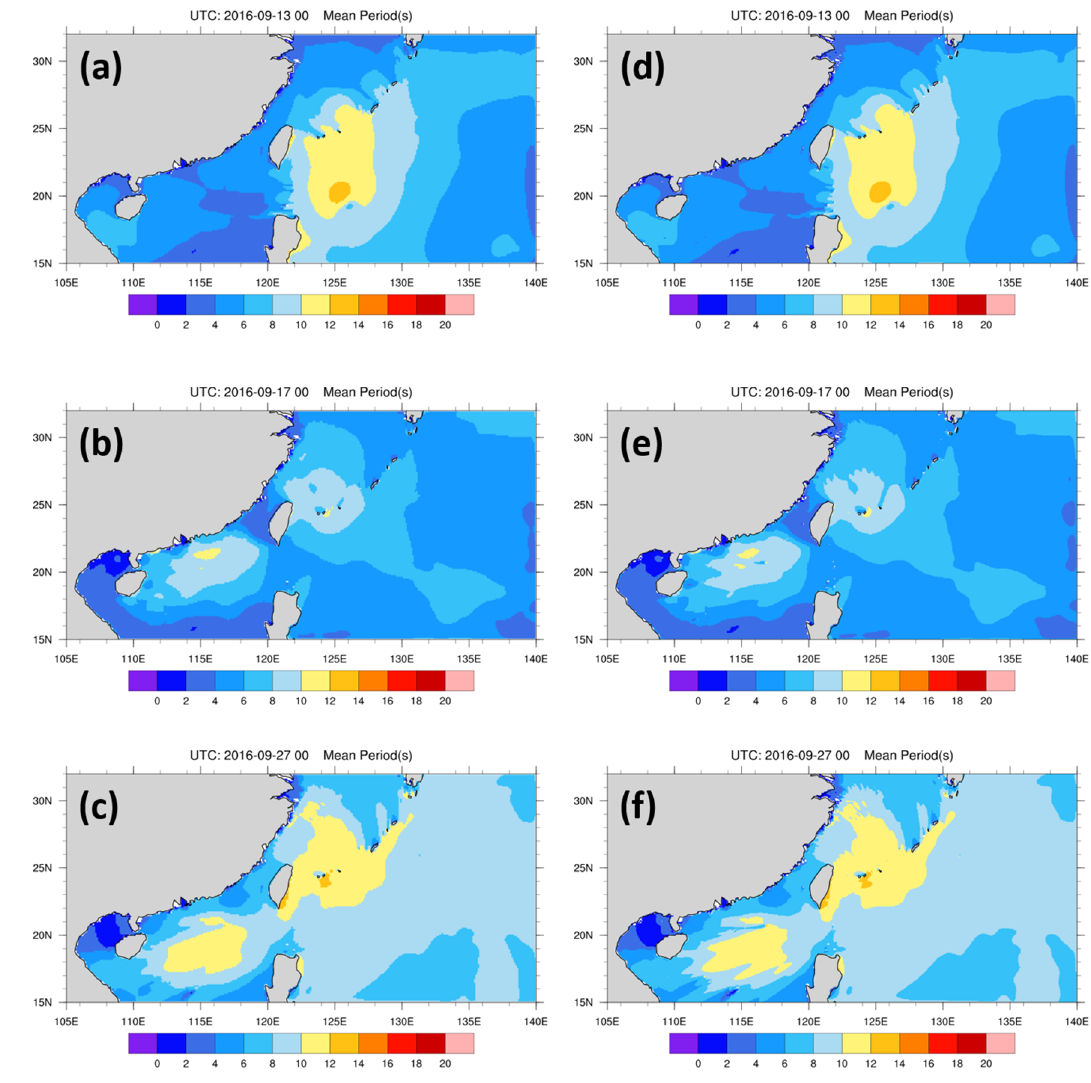
Figure 15. Spatial distribution of the mean period driven by CFSv2 using the WW3 model with 0.1 deg ( a – c ) and 0.05 deg grid resolutions for Typhoons Meranti ( a , d ), Malakas ( b , e ), and Megi ( c , f ).